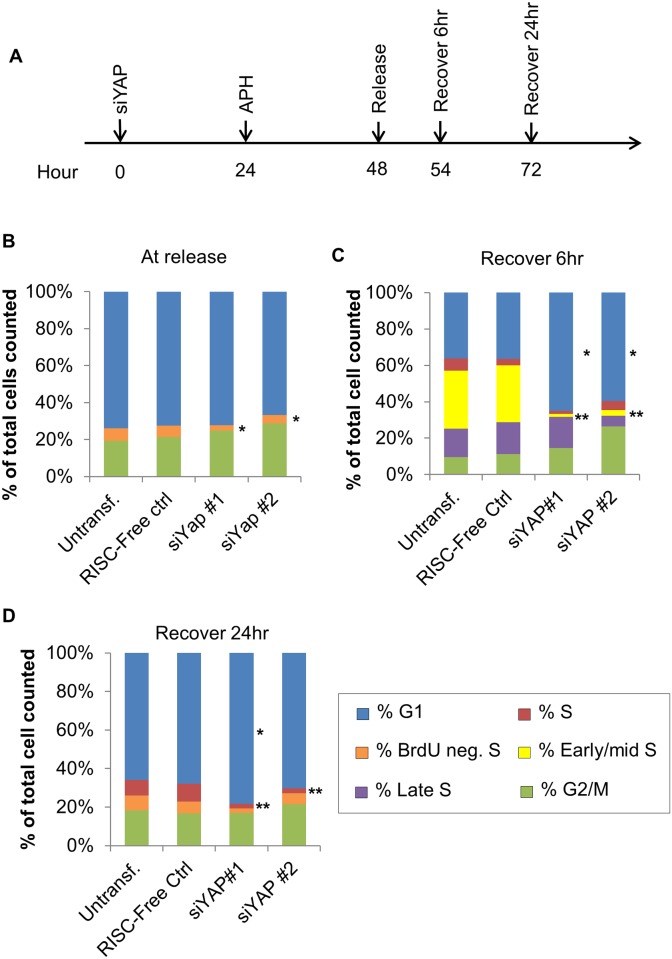
Yap is required for S-phase entry in HUVECs.A. Schematic of the APH experiment. HUVECs were treated with siRNA for 24 h then incubated with 5µM APH for 24 h. BrdU-treated HUVECs were collected at 3, 6, or 24 h post-APH removal. B. Quantification of cell cycle profiles comparing control and YAP-KD cells at the end of the 24 h APH arrest. Most of the cells captured by FACS were BrdU negative and had DNA contents of either 2N or 4N (reflecting arrest predominantly in G1 and G2/M). siYAP treatment under these conditions resulted in a further decrease of S-phase cells. p-values were calculated by comparing each phase to the corresponding datasets from RISC-free control. *, p < 0.04. C. Quantification of BrdU FACS cell cycle analysis 6 h after APH removal. Control cells were able to initiate S-phase indicated by “early S” cells. However, this population of cells was significantly reduced in siYAP-transfected cells. p-values were calculated as described in (B). * (blue bar, compared to the controls), p < 0.04. ** (yellow bar, compared to the controls), p< 0.007. D. Quantification of BrdU FACS cell cycle analysis 24 h after APH removal. siYAP-treated cells continued to exhibit decreased numbers of S-phase cells after 24 h of APH recovery. p-values were calculated as described in (B). * (blue bar, compared to the controls), p < 0.04; ** (red bar, compared to the controls), p < 0.007. See also S6 Fig.